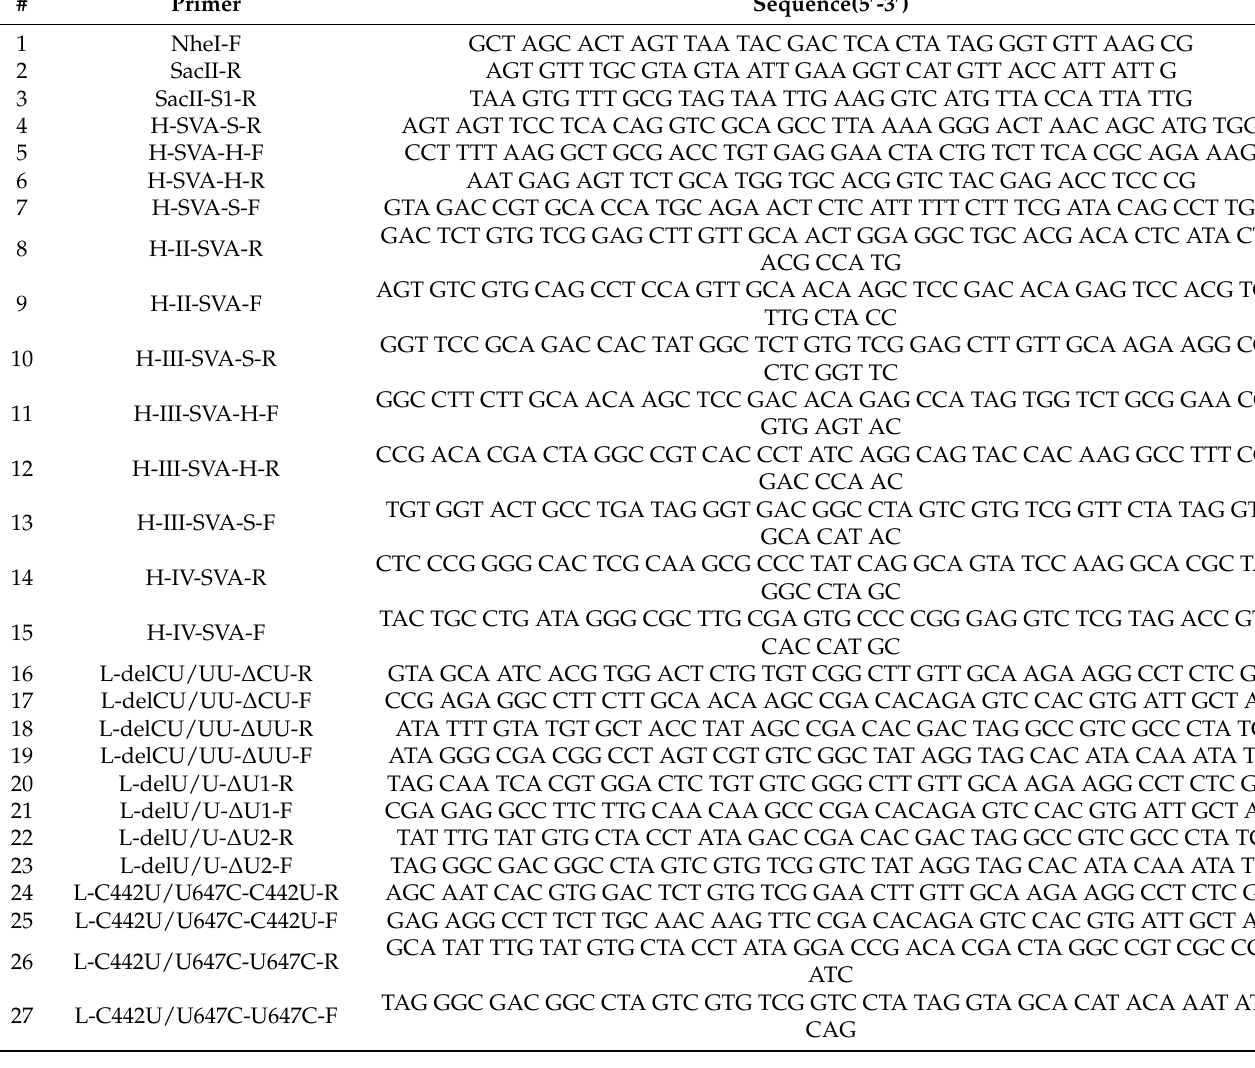
Table 1. Primers used for constructing SVA